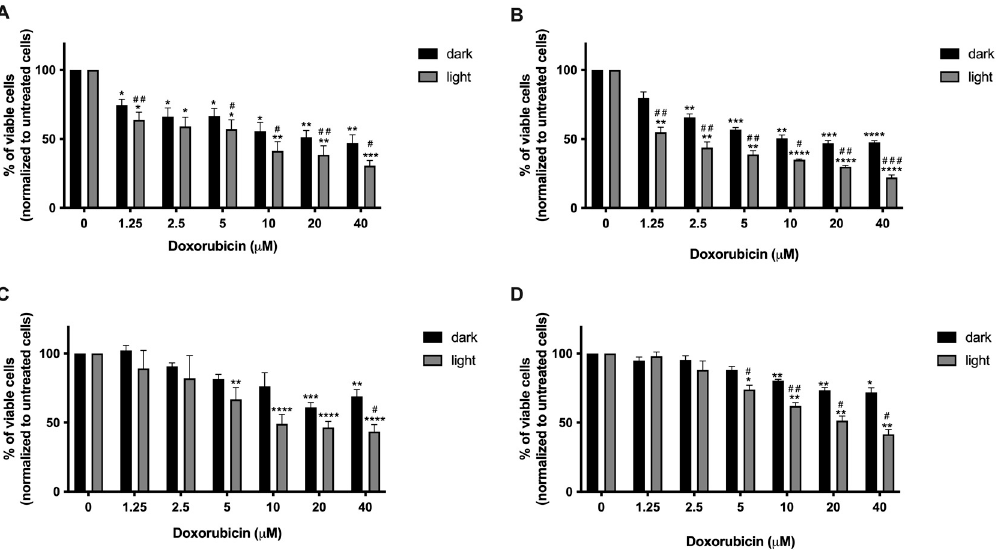
Figure 4. Percentage (%) of Jurkat ( A ), A-431 ( B ), MCF-7 ( C ), and MDA-MB-231 ( D ) viable cells after treatment with doxorubicin for 2.5 h followed or not by 30 min light irradiation and 24 h recovery in drug-free complete medium. * p < 0.05; ** p < 0.01; *** p < 0.001; **** p < 0.0001 vs. untreated cells. # p < 0.05; ## p < 0.01; ### p < 0.001 vs. nonirradiated cells. Table 1. IC 50 values, indicated as mean ± SEM (standard error of the mean), calculated after incuba- tion with doxorubicin for 2.5 h followed or not by 30 min light irradiation and 24 h recovery in drug- free complete medium.